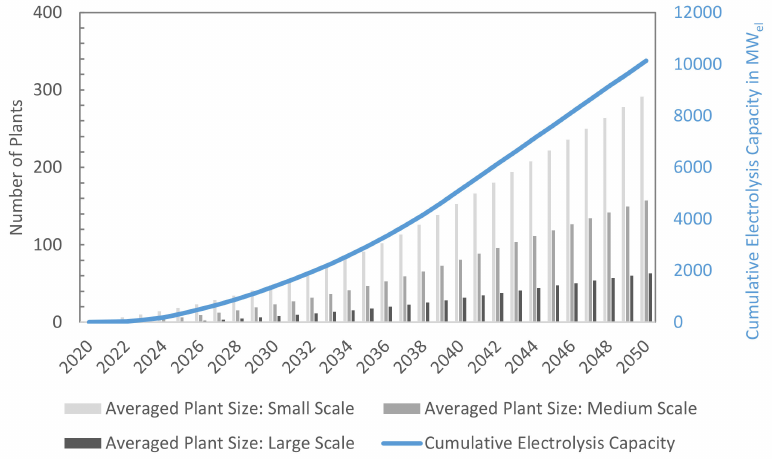
Figure 7. Roll-out curve of electrolyser plants in the scenario Sufficiency, considering economic boundary conditions